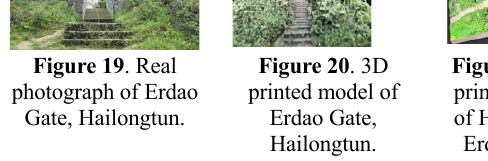
Figure 21 . 3D printed model of Hailongtun Erdao